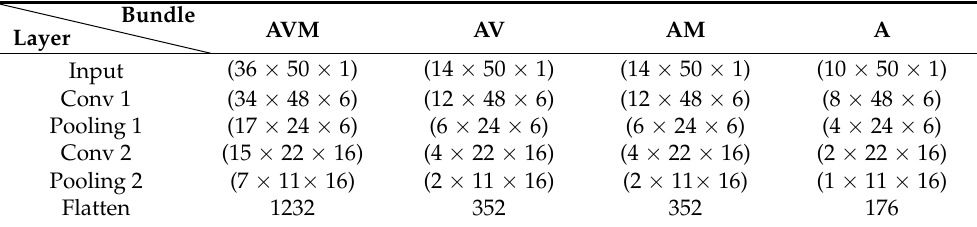
Table 5. Shapes of feature maps in each layer of LeNet5 model for different data bundles.